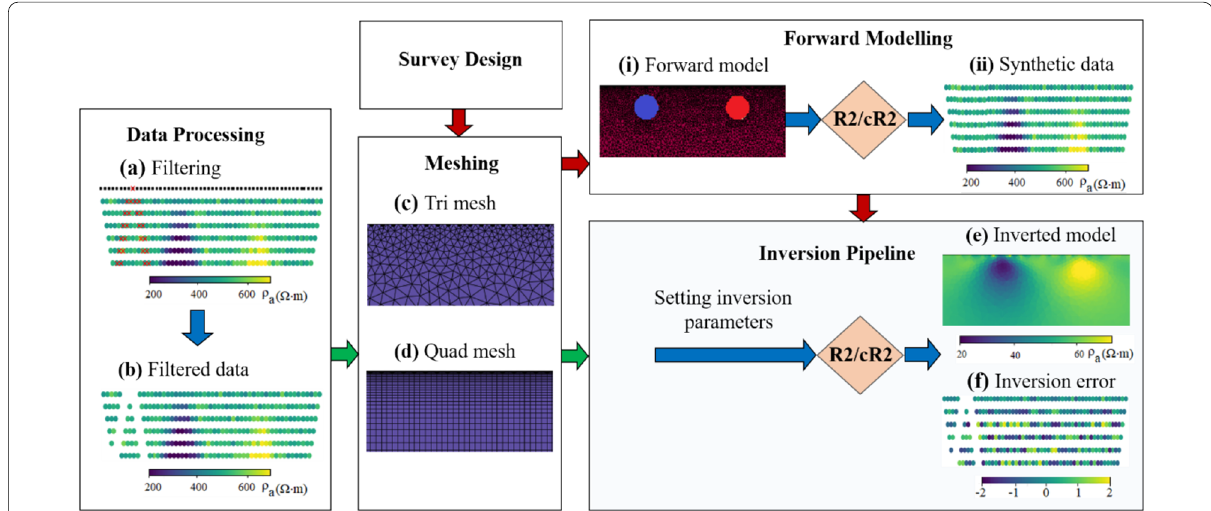
Fig. 3 ResIPy workflow. Inversion workflow (green arrows): a import the raw data and filter out the noises, b prepare data for inversion, c triangular mesh, d quadrilateral mesh, e inverted model, f normalized inversion error. Forward modelling workflow (red arrows): i synthetic model and mesh creation, and ii synthetically measure the geoelectric data (Blanchy et al.